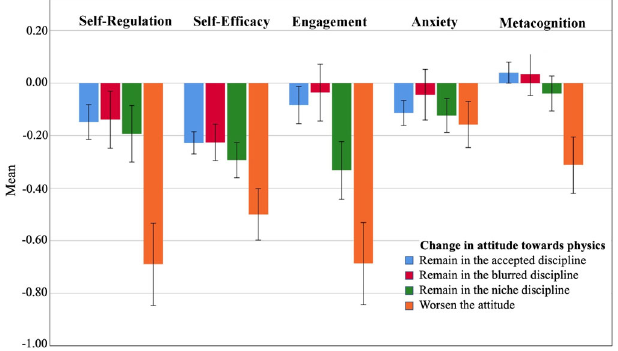
FIG. 10. Mean of the differences for the academic orientation towards physics raw scores across the four categories of change in the attitude towards physics. Whiskers indicate standard